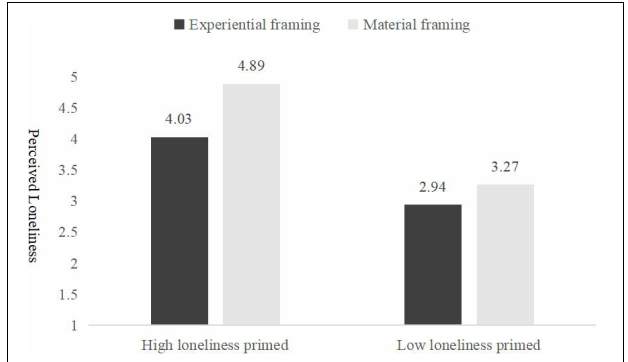
FIGURE 2 | Loneliness perception of experiential and material purchases framing (Experiment